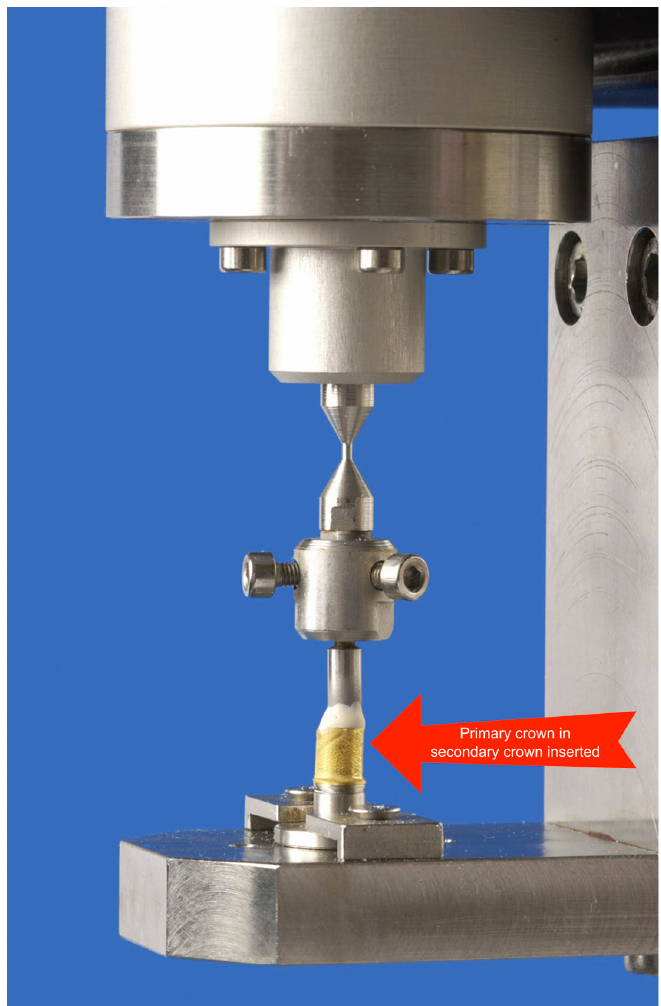
Figure 4. Detail of the Hado 2 material testing device with an integrated sample body complex. Above it, the power sensor with the predetermined breaking point can be seen.